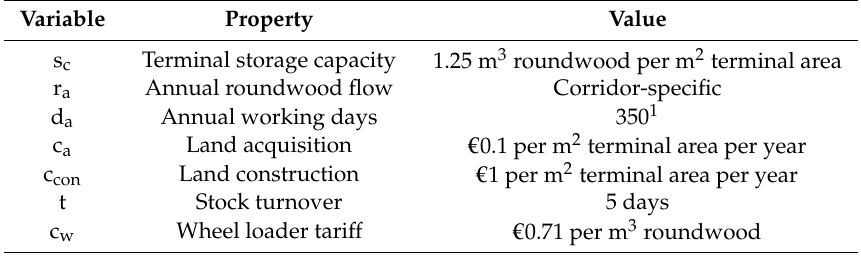
Table 3. Summary of properties and values used to calculate terminal-related costs in the study.